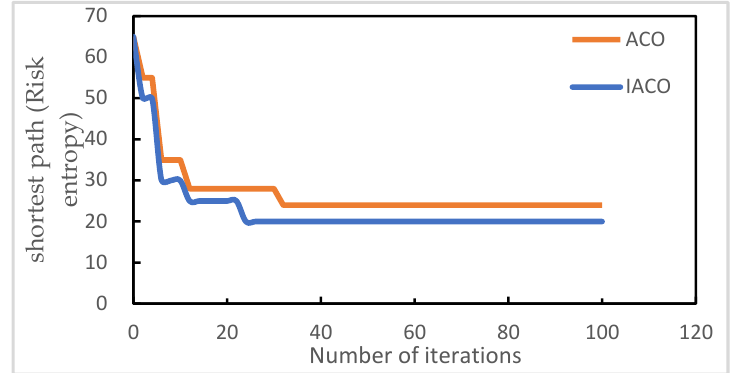
Figure 11. Shortest path comparison chart.